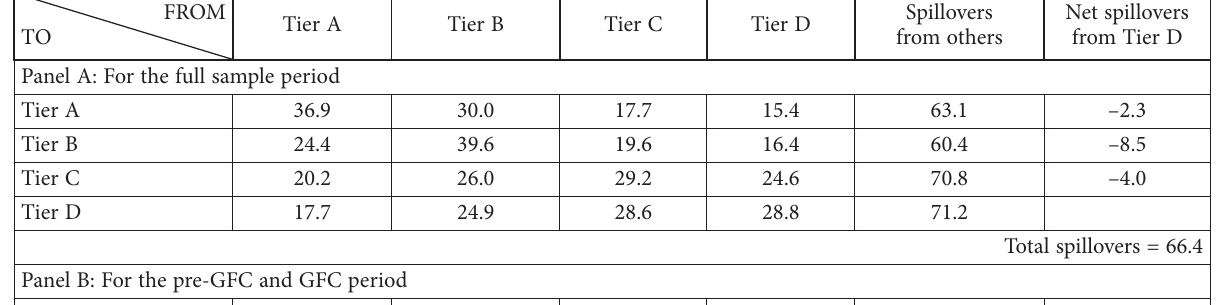
Table 4. Spillovers of price bubbles among housing tiers in percentage FROM